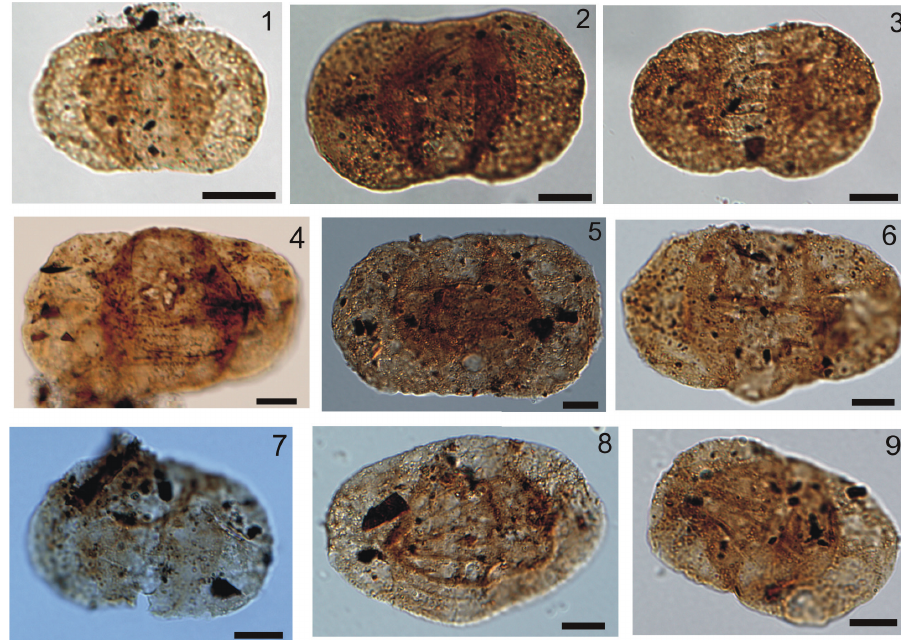
Figure 2. Species after HCl treatment. Scale bar= 20 µm in Figs. 1-3 and in the remaining is 10